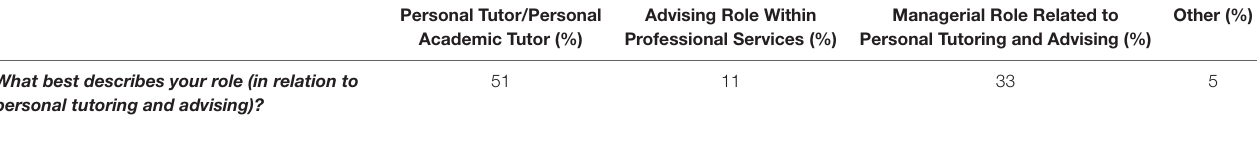
TABLE 1 | Role types of